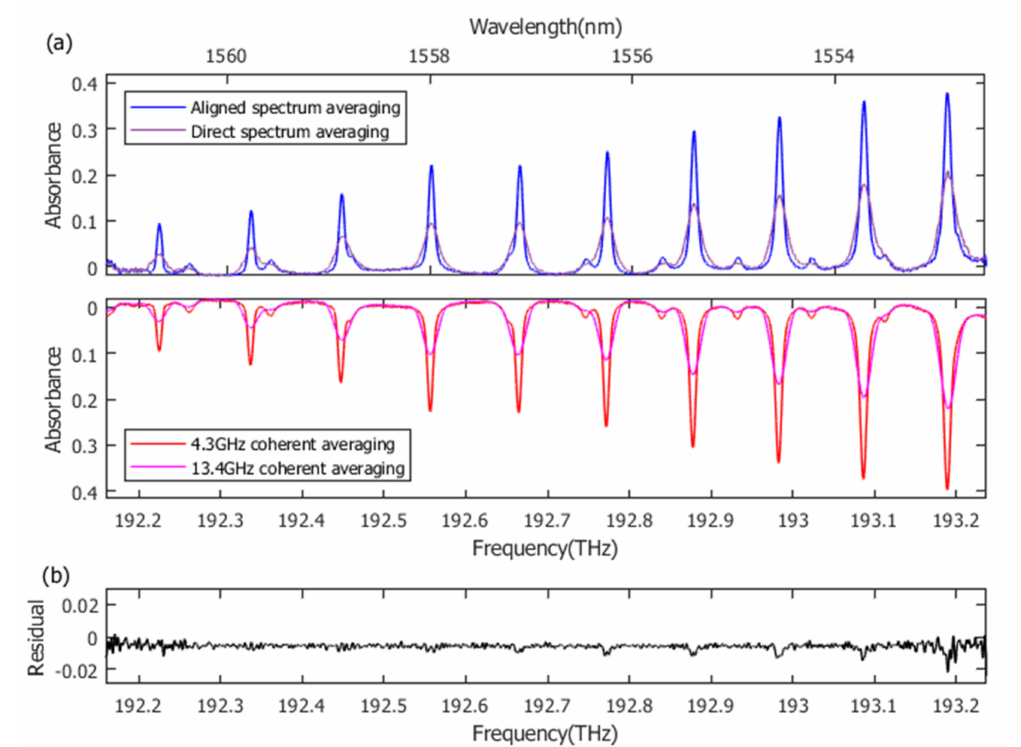
Figure 7. Absorbance spectrum over 1 s averaging. ( a ) Resolution improvement effect of aligned spectrum averaging compared to direct spectrum averaging. Meanwhile, our measured absorbance spectrum shows a great agreement with the result obtained by conventional optical reference error correction with 4.3 GHz resolution after 1 s coherent averaging, proving the practicality of our method for gas detection applications. ( b ) Residual between absorbance spectrum obtained by our method and conventional error correction with 4.3 GHz resolution. The standard deviation is ~0.002 over the 1.1 THz spectral